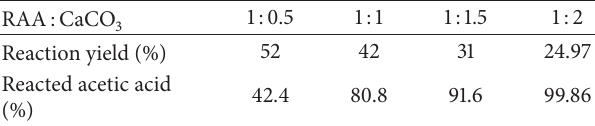
Table 6: Reaction ratio according to weight ratio of RAA: CaCO 3 .